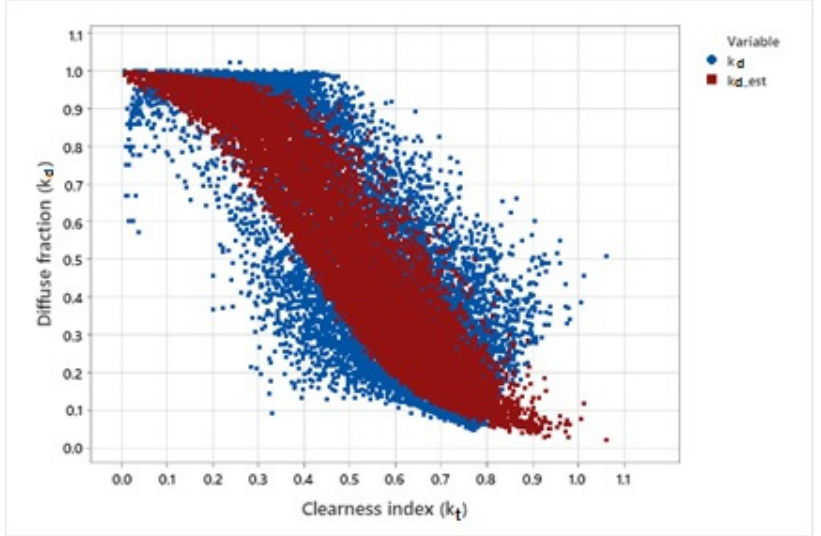
Figure 23. The BRL diffuse fraction model fit with the clearness index ( k t ).